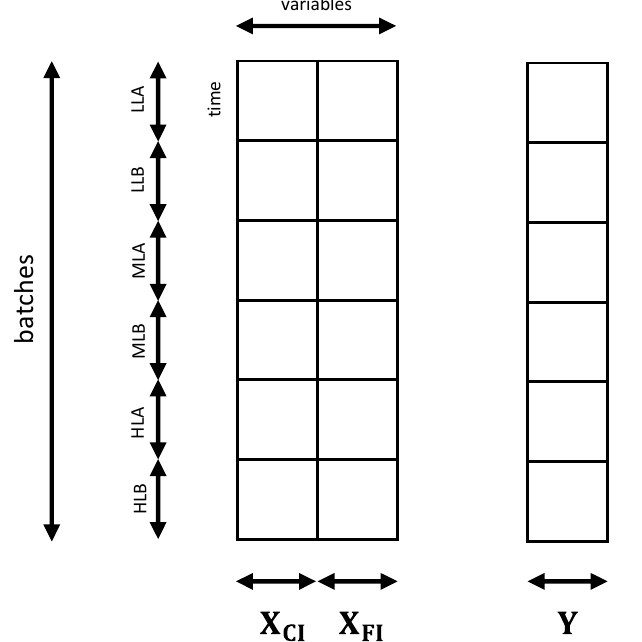
Figure 2. Matrices used to build the PLS models to estimate biomass concentration. The predictor matrix 𝐗 was built concatenating 𝐗 𝐂𝐈 and 𝐗 𝐅𝐈 depending on the model. The response matrix 𝐘 [144 × 1] consisted of the biomass concentration or in its logarithm, depending on the model.